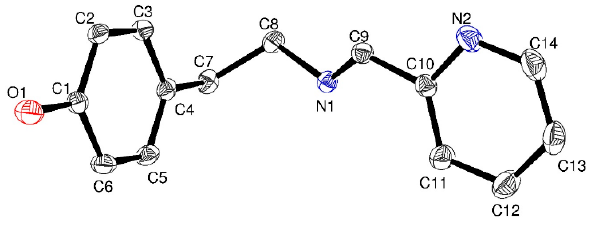
Figure 3. Crystal structure of compound 2 .